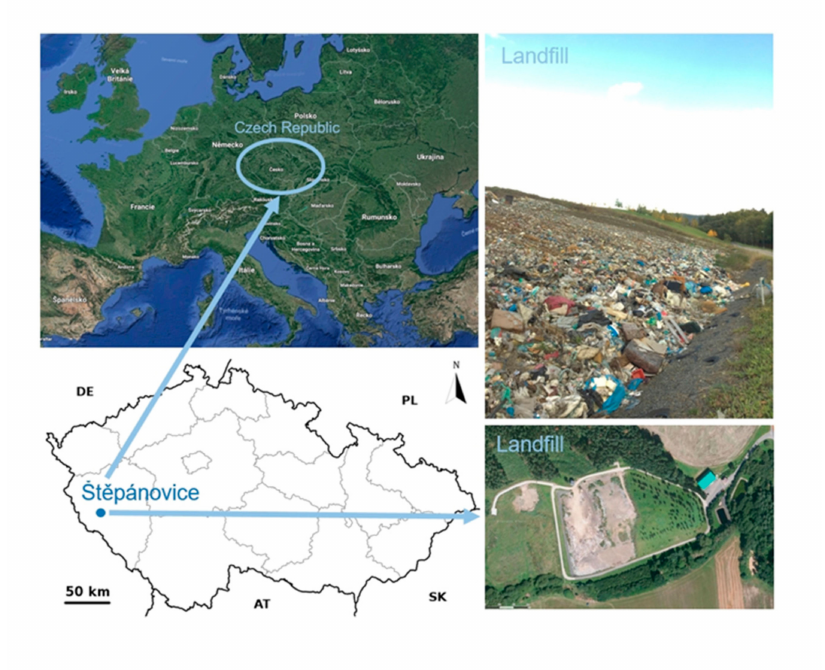
Figure 1. The location of the Štˇep á novice